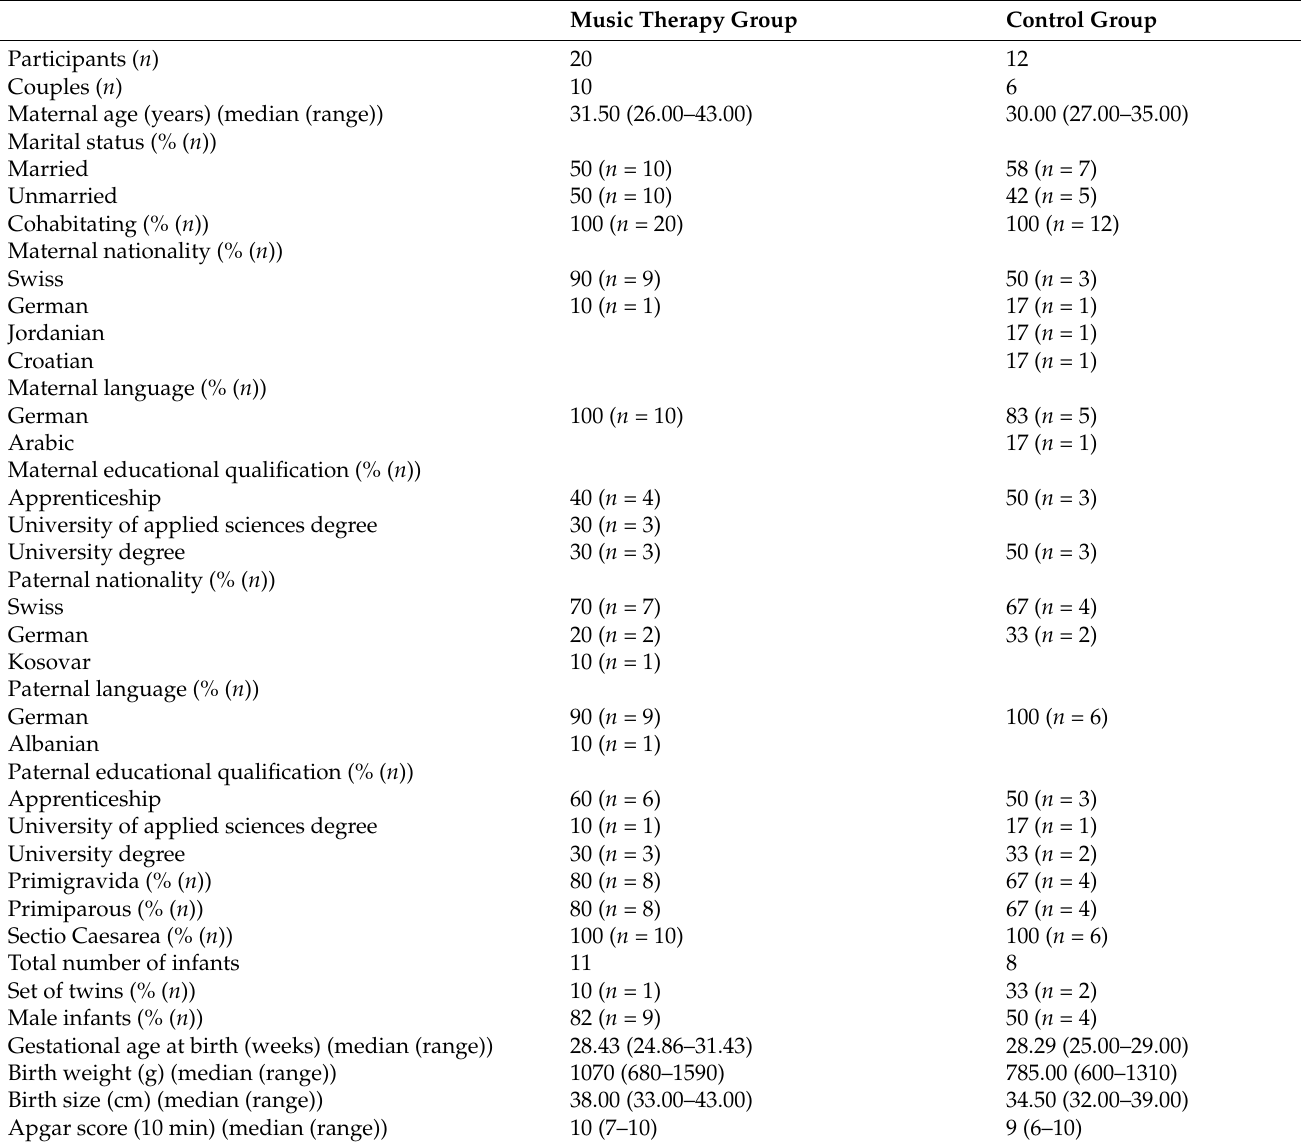
Table 1. Characteristics of the study population ( N =